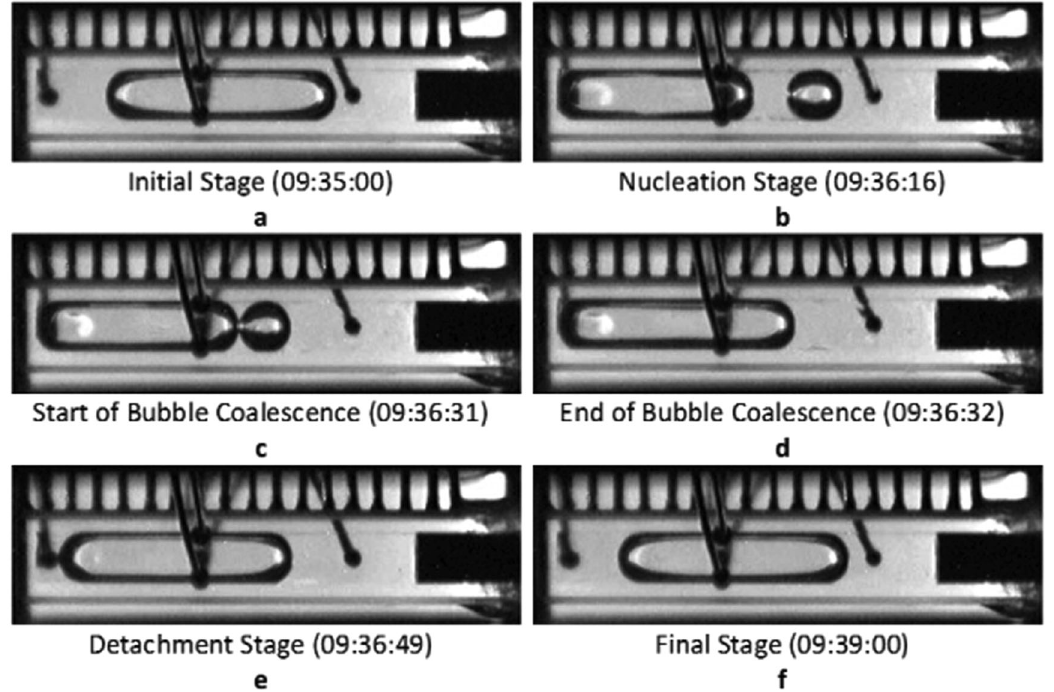
Fig. 3 Nucleation event milestones 43 . a Initial state with bubble near the middle of the device. b Moment of the nucleation event. A new bubble was generated at the hot end by evaporation of the liquid phase. The original bubble in ( a ) collapsed with the sudden increase in the system pressure. c The start of the bubble merging process for the new and the original bubble. d The end of the merging process for the two bubbles. At this moment, the combined bubble was still attached to the heater wall. e Progression of the bubble back toward its initial location. f Return of the bubble to its initial location.